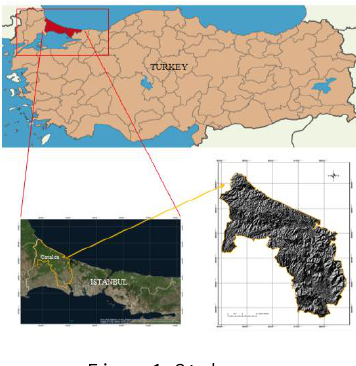
Figure 1. Study area